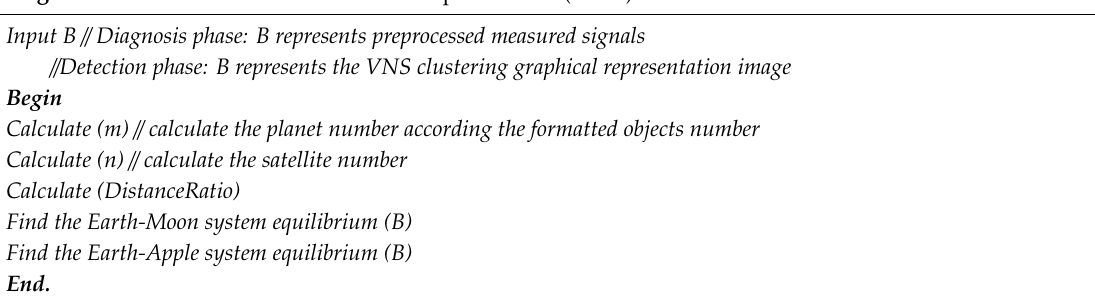
Algorithm 7. Classical Mechanics-based Optimization (CMO).